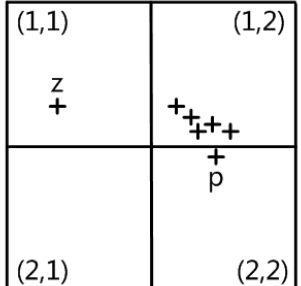
Figure 6. Difficult to distinguish between boundary point grids and noise point grids by cumulative contribution.